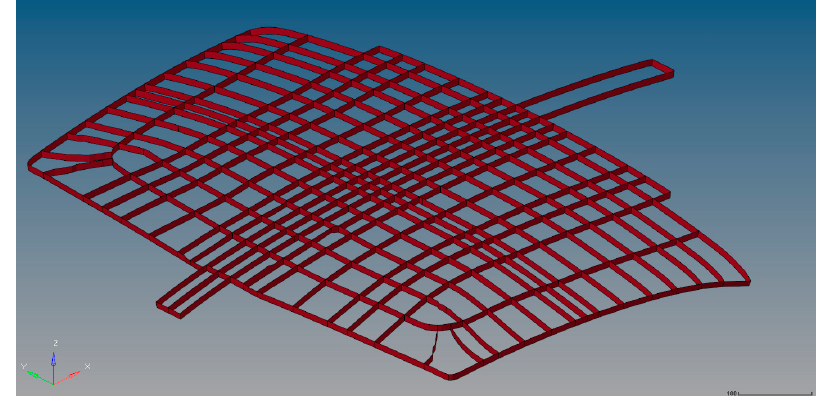
Figure 14. Car roof stiffening in the new optimized PP23CF configuration.